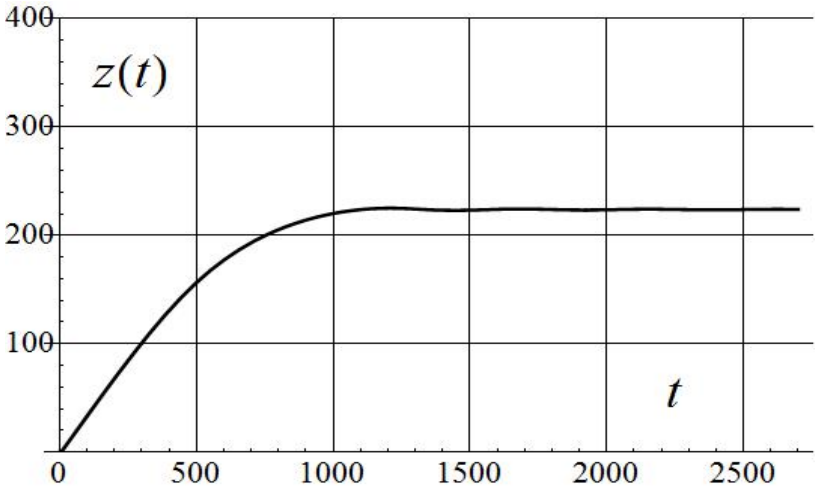
Figure 25. Submersion versus time: equatorial waters, sphere, l ∗ = l s = 1/3, η = 0.005.